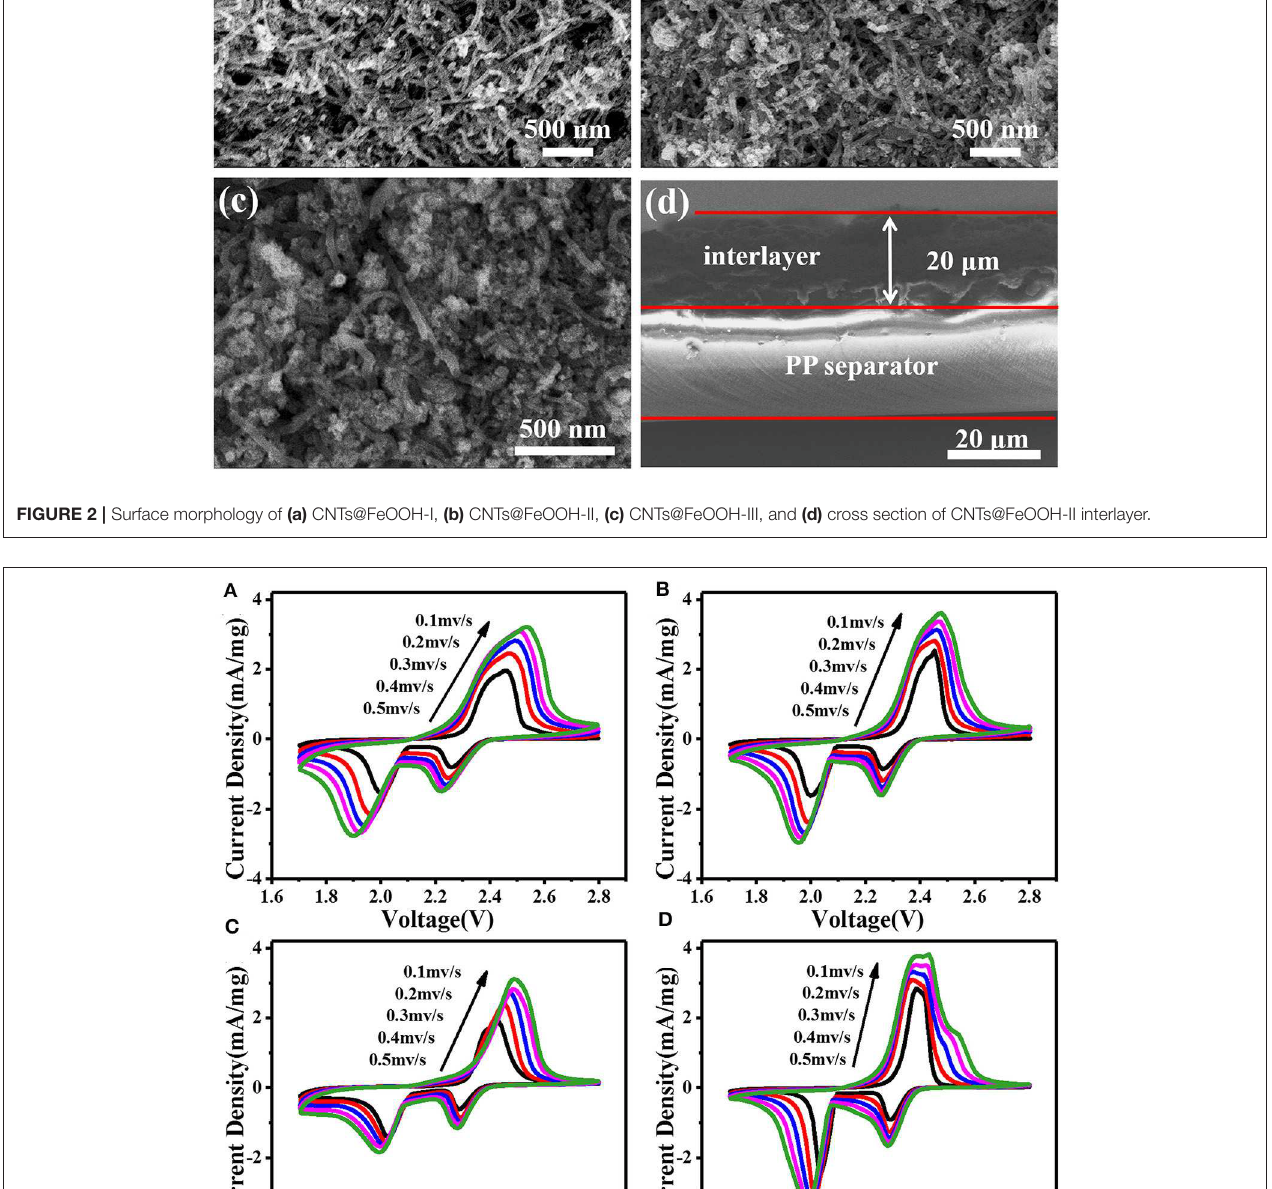
distinct cathode peaks and one anode peak. The cathode peak at about 2.3 V corresponds to the transformation of sulfur bonding with Li + into soluble long-chain polysulfide [Li 2 S x (x = 4–8)].